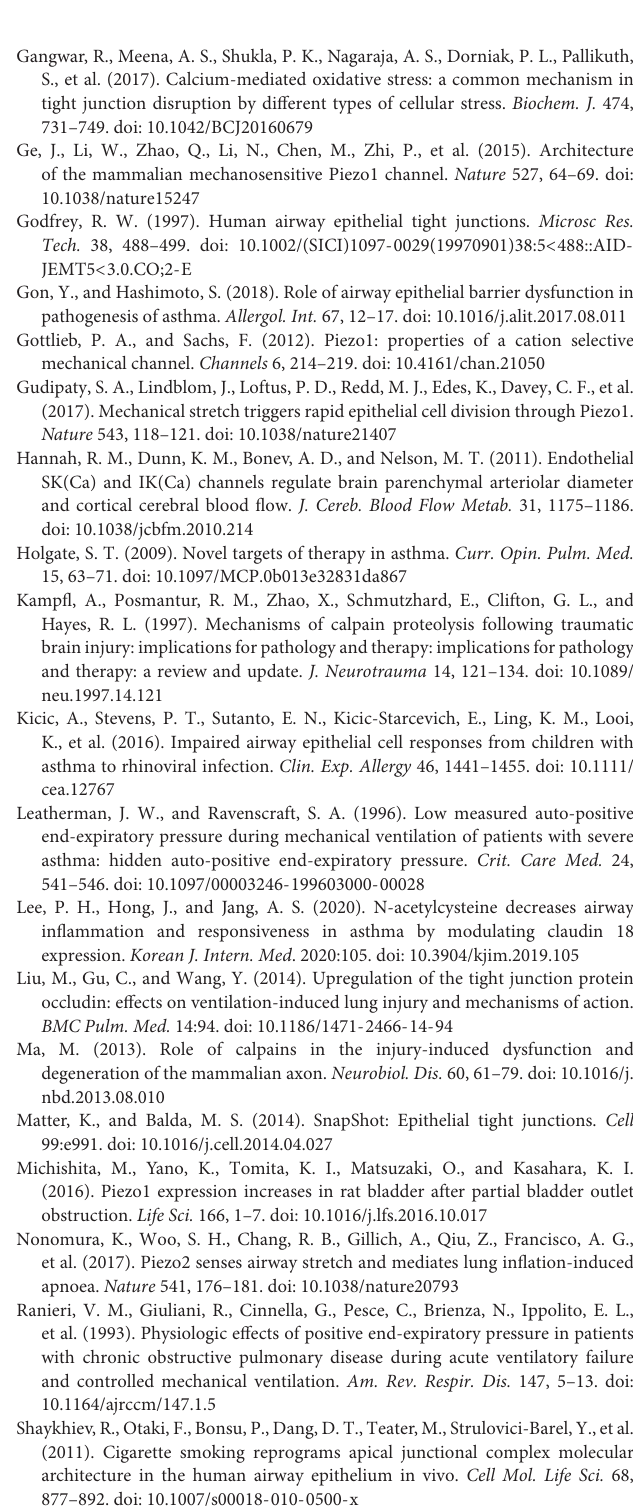
described as relative expression normalized to that of β -actin. Data are represented as the mean ± SD, n = 6. ∗ P < 0.05 vs. wild-type (WT)